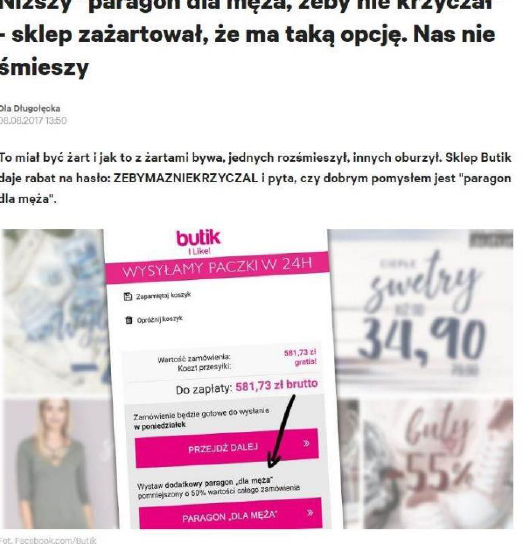
Figure 3. Lower “receipt for a husband so that he did not shout”— a shop made a joke that it has such an option.